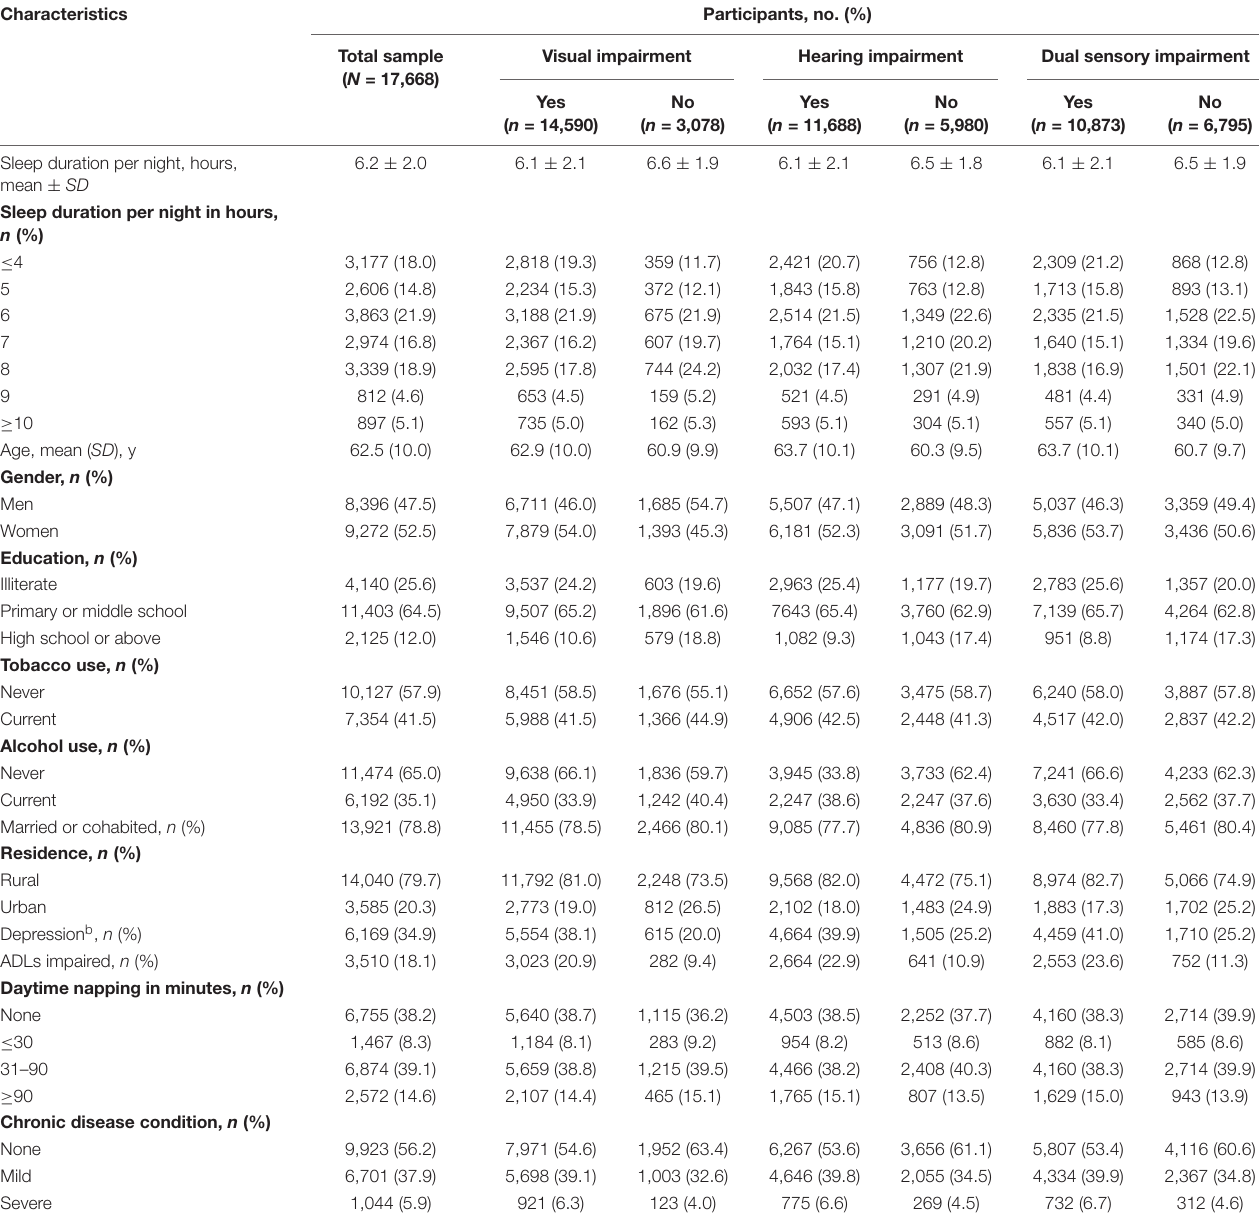
TABLE 1 | Characteristics of participants from 2018 China Health And Retirement Longitudinal Study, by sensory impairment status a